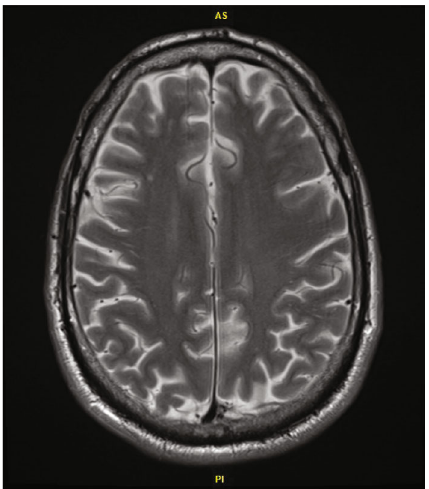
Figure 9: Follow-up MRI showing resolution of